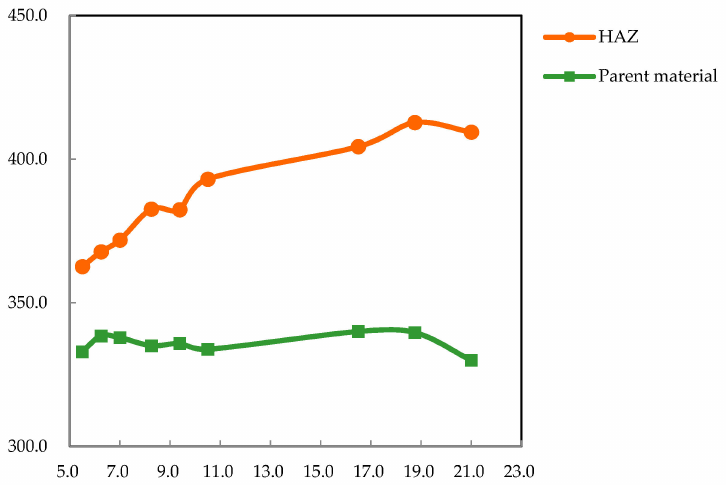
Figure 9. Relationship between the average microhardness and line energy for the HAZ and parent